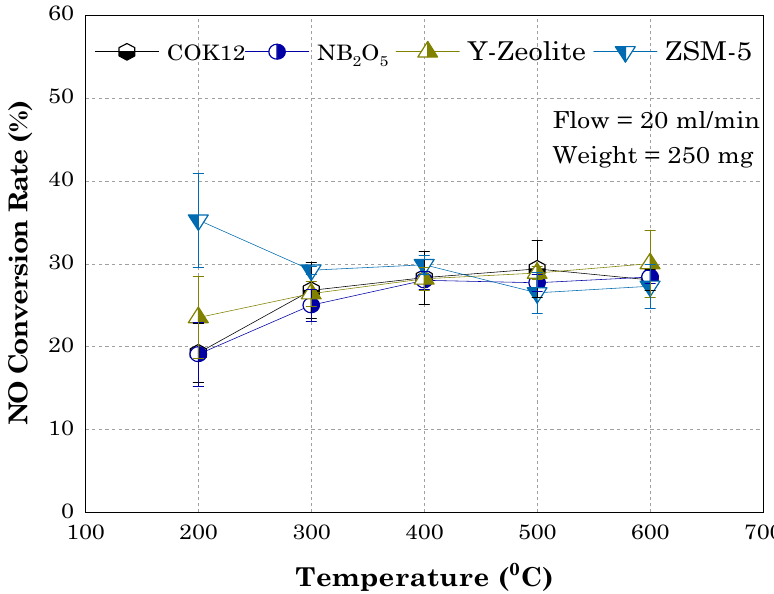
Figure 11. NO conversion rates vs temperature for various supports. Figure 11 represents the NO conversation rate with temperature, for COK12 & Cu- COK12, Nb 2 O 5 & Cu-Nb 2 O 5 , Y-Zeolite & Cu- Y-Zeolite and ZSM5 & Cu- ZSM5. Here, 250 mg catalyst was used, and the gas flow rate was maintained at 20 mL/min. Figure 12a represents the NO conversion rate for ZSM5 and Cu-ZSM5. Without Cu metal (ZSM5), NO conversion rate was ~35.2, 29.2, 29.8, 26.5, and 27.3% at temperatures of 200, 300, 400, 500, and 600 ◦ C, respectively. With Cu doping (Cu-ZSM5) NO conversion rate jumped to ~40.6, ~34.2, ~35.5, 34.1 and 32.2% at 200, 300, 400, 500 and 600 ◦ C temperature, respectively. Figure 12b represents the NO conversion rate for Y-Zeolite & Cu-Y-Zeolite. Without the use of active metal, Y-zeolite was able to convert NO with ~23.5, 26.3, 28.1, 28.8, and 30.0% conversion rate at 200, 300, 400, 500, and 600 ◦ C, respectively. The combination of support and active metal (Cu- Y-Zeolite) enhanced NO conversion significantly compared to unloaded support, i.e., ~141.0, 117.2, 101.3, 106.5, 89.4% increase in conversion percentage at 200, 300, 400, 500, and 600 ◦ C temperatures, respectively. Figure 12c represents the NO conversion rate for Nb 2 O 5 and Cu- Nb 2 O 5 . NO conversion rate for Nb 2 O 5 was ~19%, ~25%, ~28%, ~27.7%, ~28.4% at 200, 300, 400, 500 and 600 ◦ C temperature, respectively. The influence of Cu presence was negligible in terms of NO conversion rate, especially at a higher temperature range. For Cu-Nb 2 O 5 NO conversion rate was increased by ~64.2%, ~16.3%, ~3.9%, and ~9.3% at 200, 300, 400, and 500 ◦ C, respectively. However, it was decreased by ~3.8% at 600 ◦ C. Figure 12d represents the NO conversion rates for COK12 & Cu-COK12 with temperatures. It can be seen that without any active metal also,